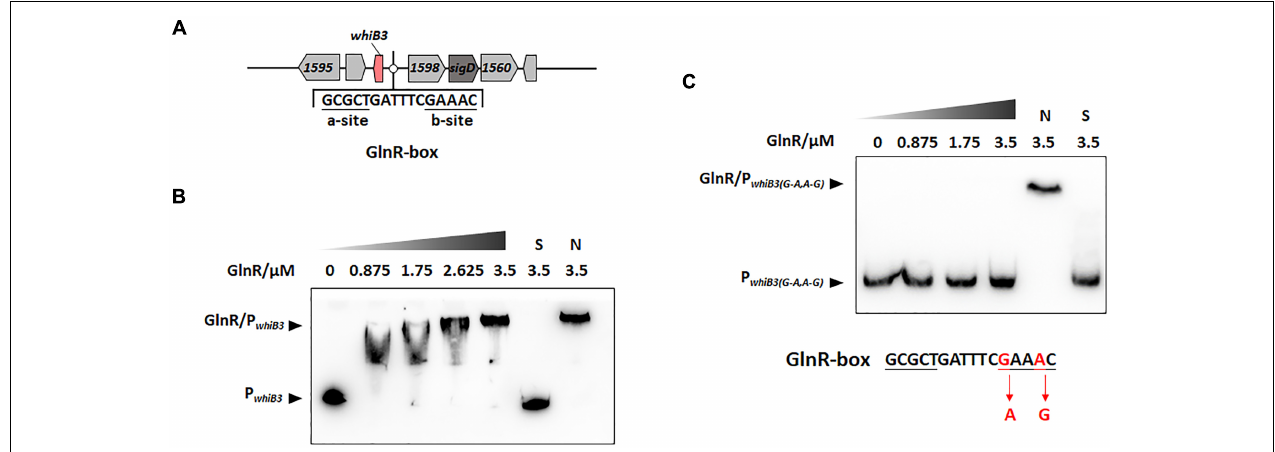
FIGURE 1 | GlnR binding with the upstream promoter region of whiB3 in M. smegmatis . (A) GlnR-binding site (GlnR-box) in whiB3 promoter region. (B) EMSA of purified GlnR with the whiB3 promoter region. 10 nM DNA probes were incubated with a gradient concentration of purified GlnR. (C) EMSAs of purified GlnR protein with mutated whiB3 promoter